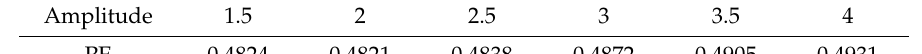
Table 3. The permutation entropy values corresponding to different amplitude of impulse signal. Amplitude